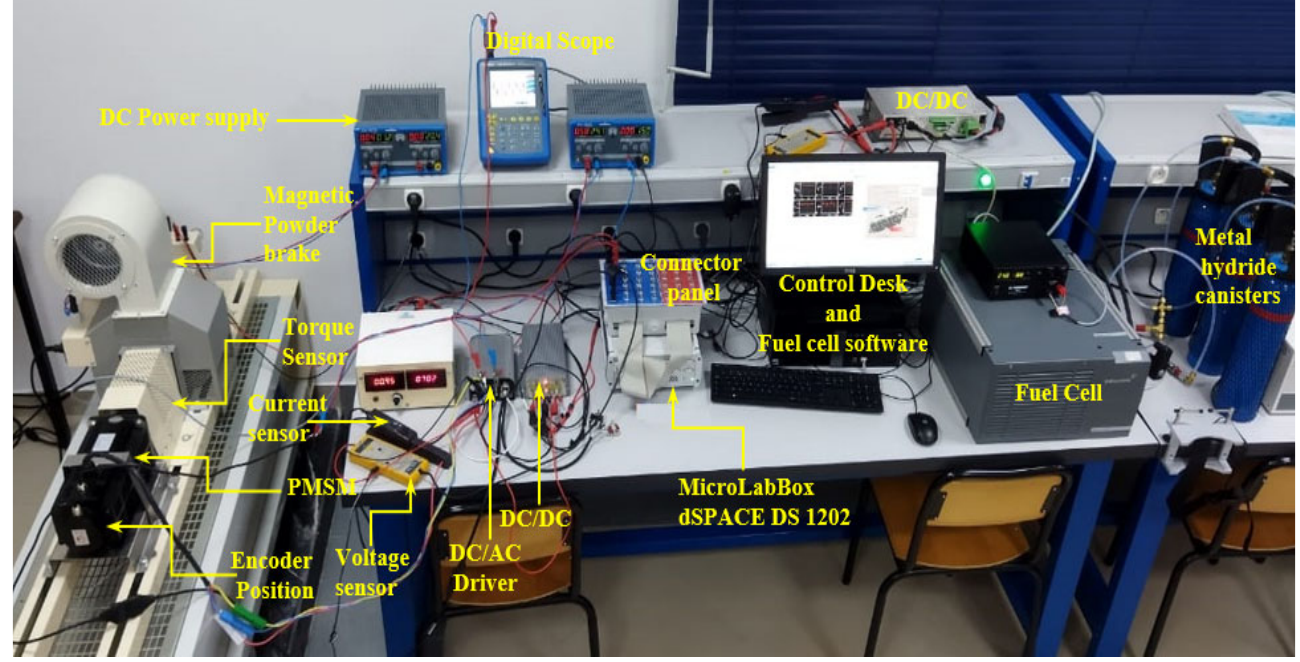
Figure 19. Laboratory prototype used for experimental validation.